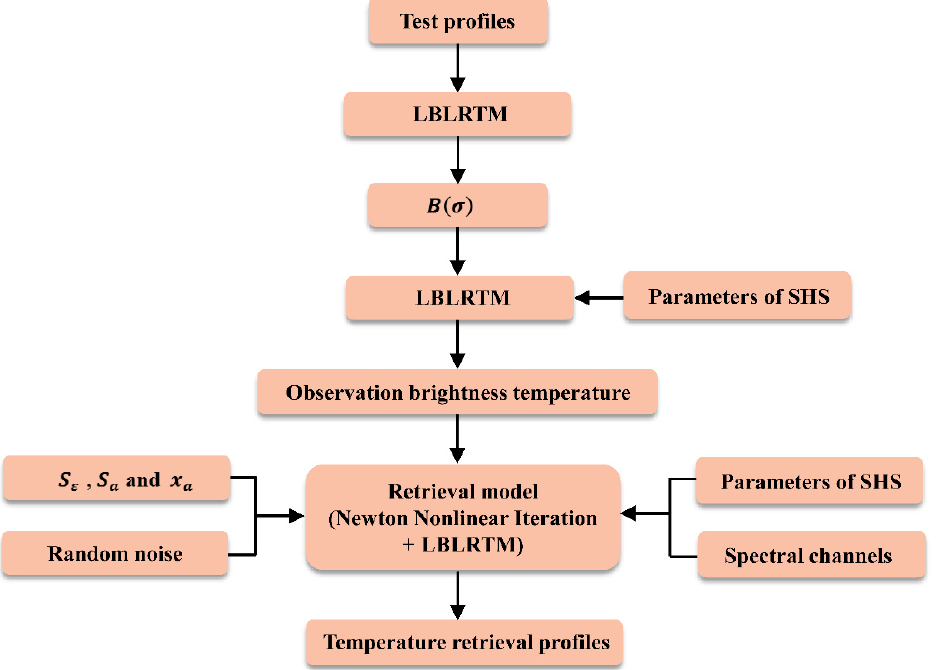
Figure 5. The processing flowchart of the simulation. ( S ε is the observation error covariance matrix, a diagonal matrix, and the diagonal element is the square of the instrumental noise [49]. x a is the a priori profile. S a is the a priori error covariance matrix which is obtained from the deviation statistics of x a and the temperature profile of the training data [27]. Gaussian-distributed random noise with a zero mean and a standard deviation equal to NeDT is added to the calculated observation brightness temperature to simulate actual satellite data [49].)